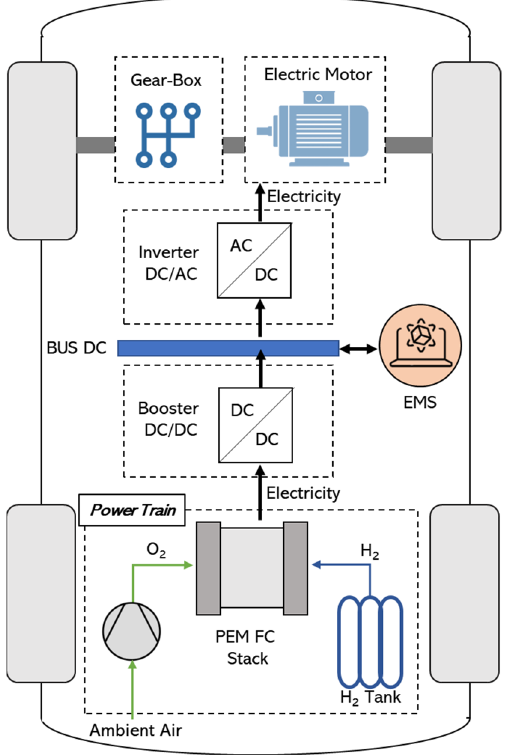
Figure 3. Total fuel cell Electric Vehicle.